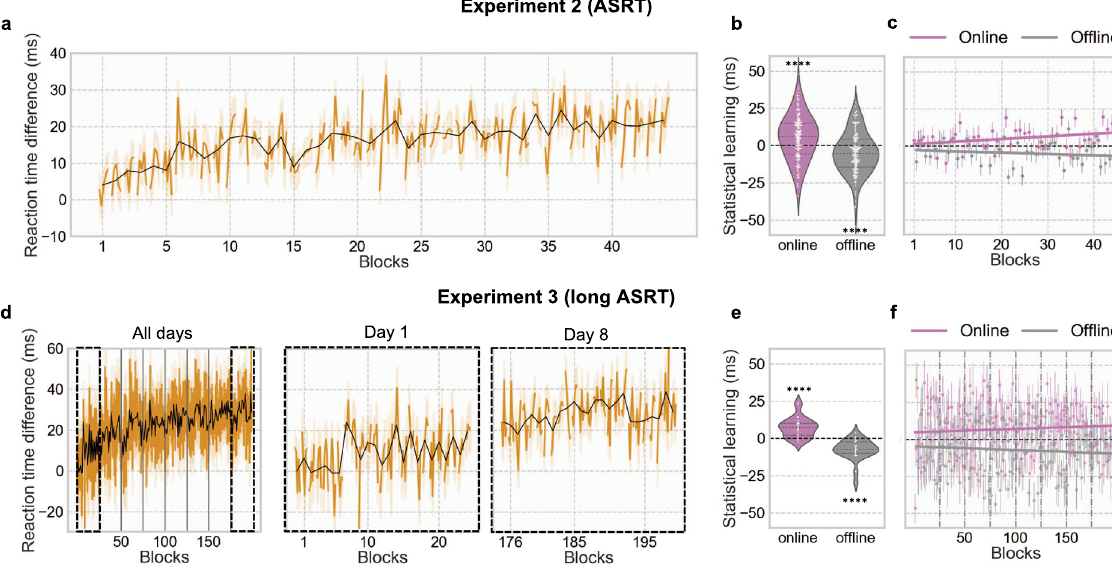
Fig. 3 Statistical learning occurs during practice periods. a Average statistical learning (RT difference between random-high and random- low trials) per block (black line) and per bin (orange line) for Experiment 2 (ASRT). b Average online and of fl ine statistical learning across all blocks for Experiment 2 (ASRT). c Online and of fl ine statistical learning across all blocks and with a linear fi t for Experiment 2. d Average statistical learning per block (black line) and per bin (orange line) for Experiment 3 (long ASRT). For better visualization, a zoom-in for day 1 and day 8 is represented. e Average online and of fl ine statistical learning across all blocks with a linear fi t for Experiment 3 (long ASRT). f Online and of fl ine statistical learning across all blocks for Experiment 3 (long ASRT). Signi fi cance is noted by four asterisks (****) for p value <0.0001. Note that higher values mean greater learning. Error bars represents standard